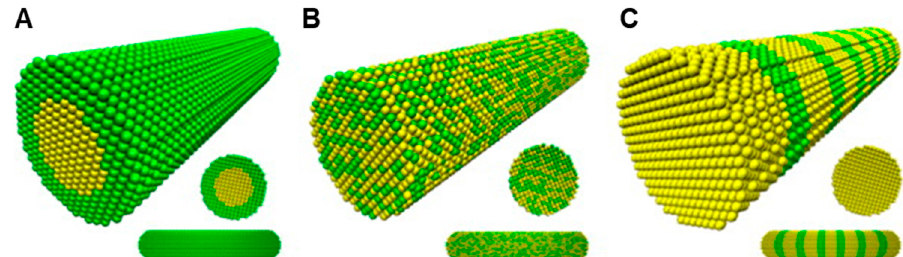
Figure 2. Schematic illustration of three mixing patterns in zero-dimensional bimetallic nanomaterials: ( A ) core–shell, ( B ) dumbbell and ( C ) alloyed (adapted with permission from [56], Elsevier, 2013).